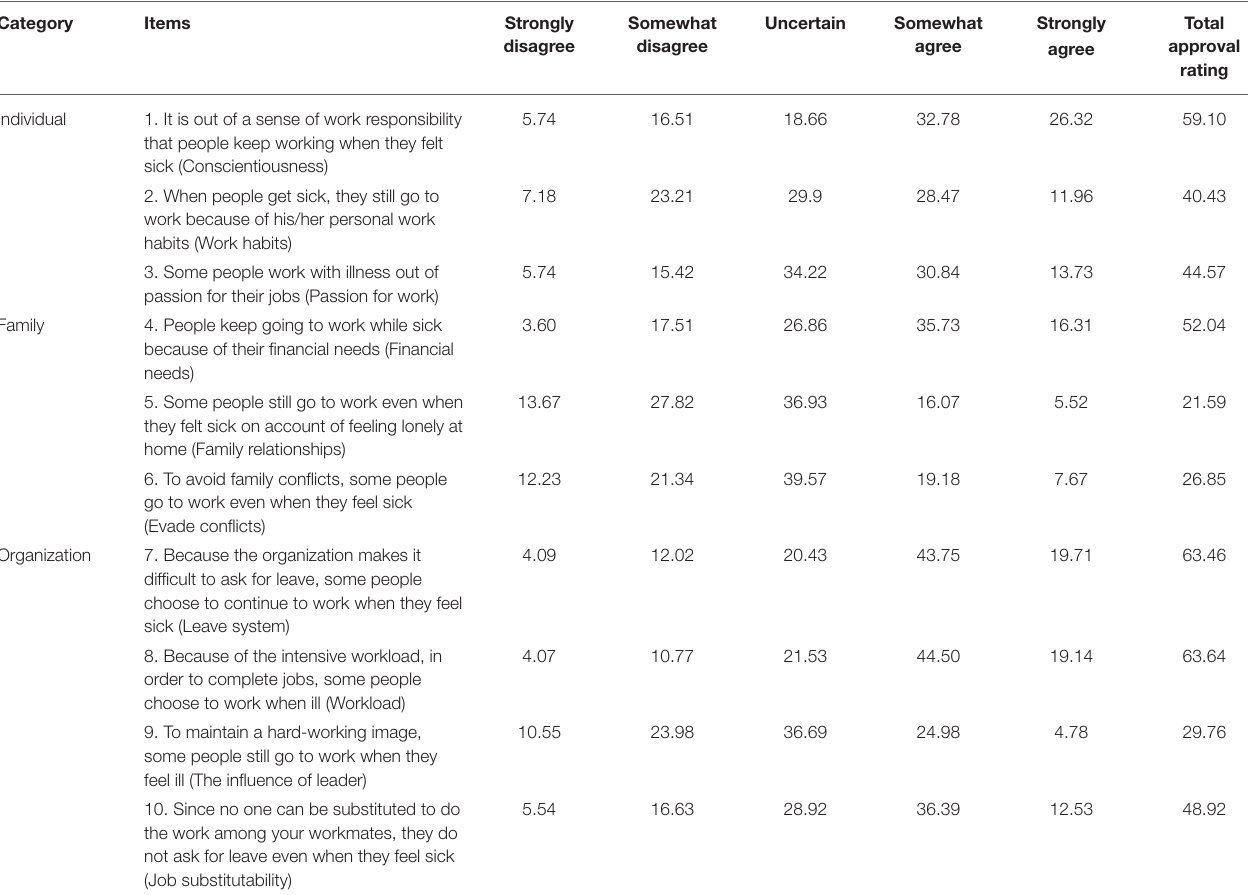
TABLE 3 | Approval rating of presenteeism causes among nurses (%). Category